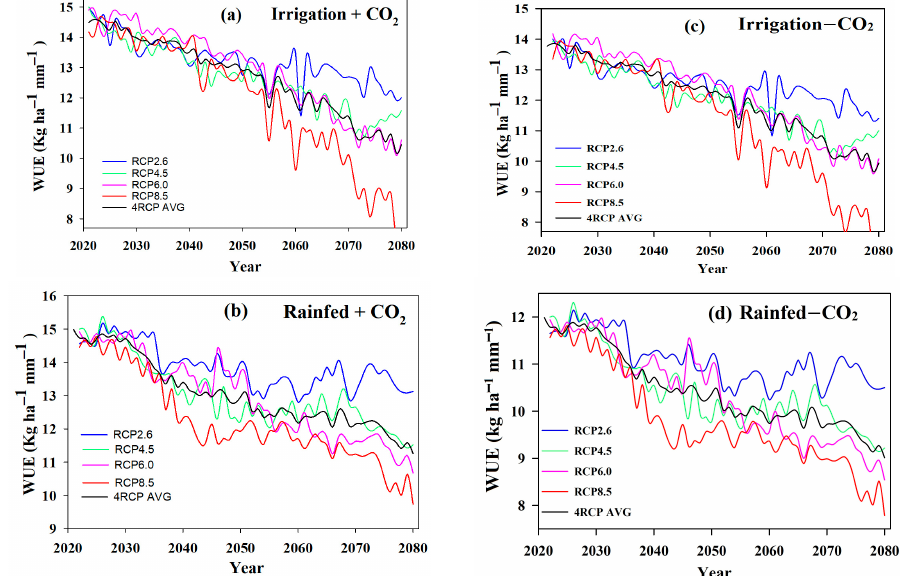
Figure 7. Temporal evolutions of the maize crop water use efficiencies with and without increased CO 2. ( a ) Irrigation + CO 2 ( b ) Rainfed + CO 2 ( c ) Irrigation − CO 2 ( d ) Rainfed − CO